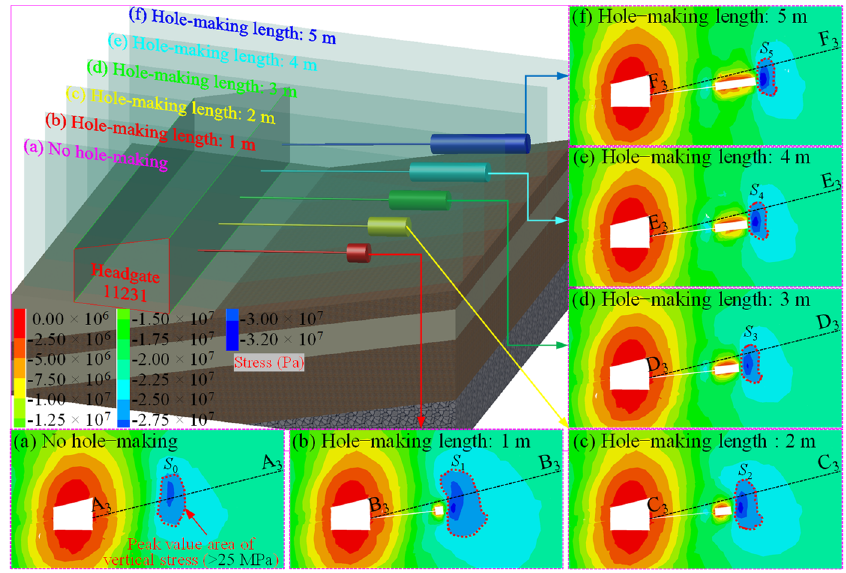
Figure 13. Layout scheme under different hole-making lengths and distribution nephogram of vertical